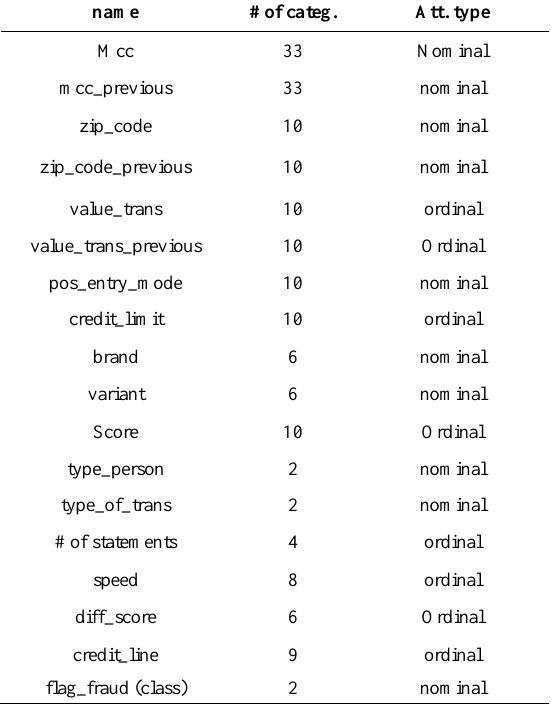
Table 1. Number of categories for each variable.